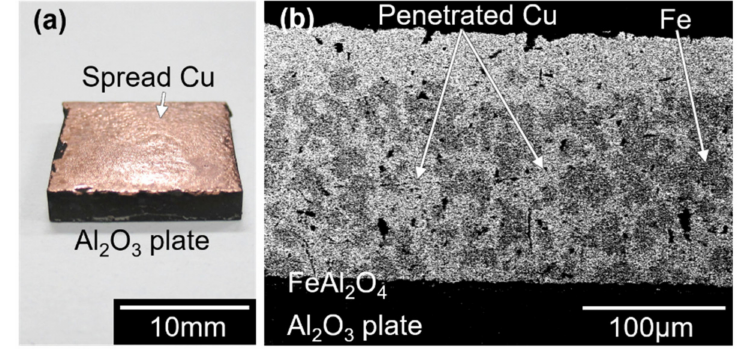
Figure 6. ( a ) Appearance and ( b ) cross-section of sample after copper metalizing.